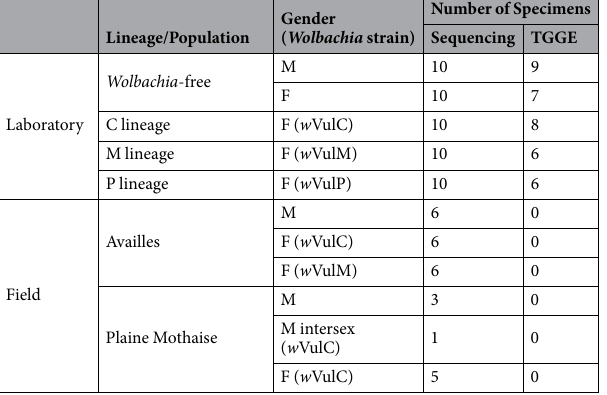
Table 1. Origin, infection status and number of specimens used for 16S rRNA gene amplicon sequencing and/ or TGGE fingerprinting. Individuals were pooled for amplicon